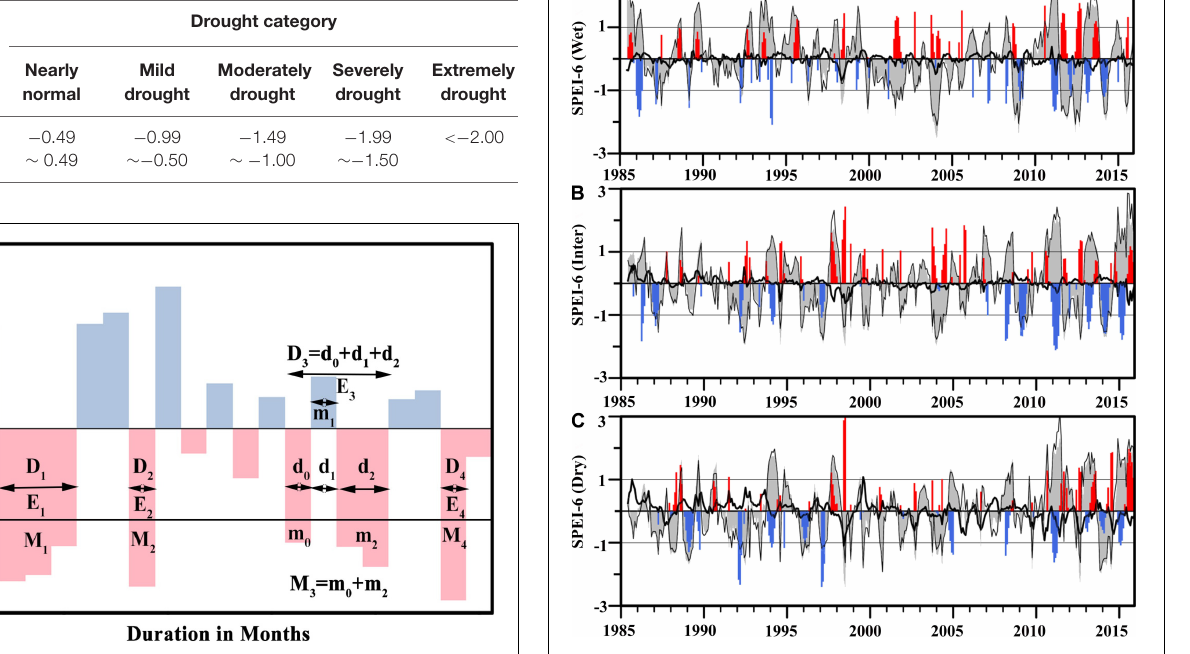
FIGURE 2 | Schematic diagram for drought characteristics based on run theory. For the drought event E 1 , E 2 , E 3 , and E 4 , the relevant doughty duration (D) and severity (M) are D 1 , M 1 ; D 2 , M 2 ; D 3 , M 3 ; and D 4 , M 4 , respectively. The black line represents the threshold limit (–1) for identifying the drought event. For drought event E3 with interruption period (d1) less than or equal to 2 months, the duration (severity) of subdivisions of the E 3 is d 0 , d 1 , d 2 (m 0 , m 1 , m 2 ), respectively. Then duration of drought event E 3 is obtained as: D 3 = d 0 + d 1 + d 2 ; Severity is obtained as: M 3 = m 0 + m 2 . This Figure is redrawn according to the Yevjevich et al. (1967).